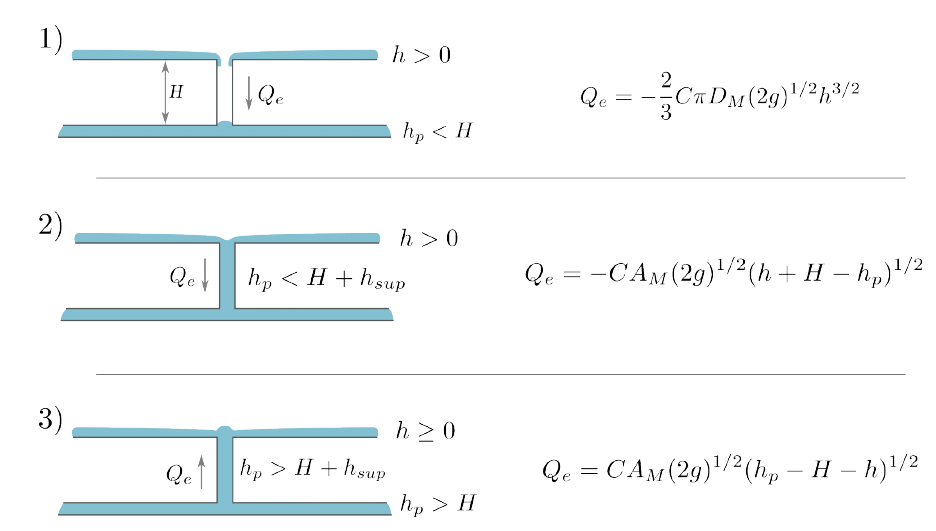
Figure 1. Possible hydraulic scenarios in the coupled